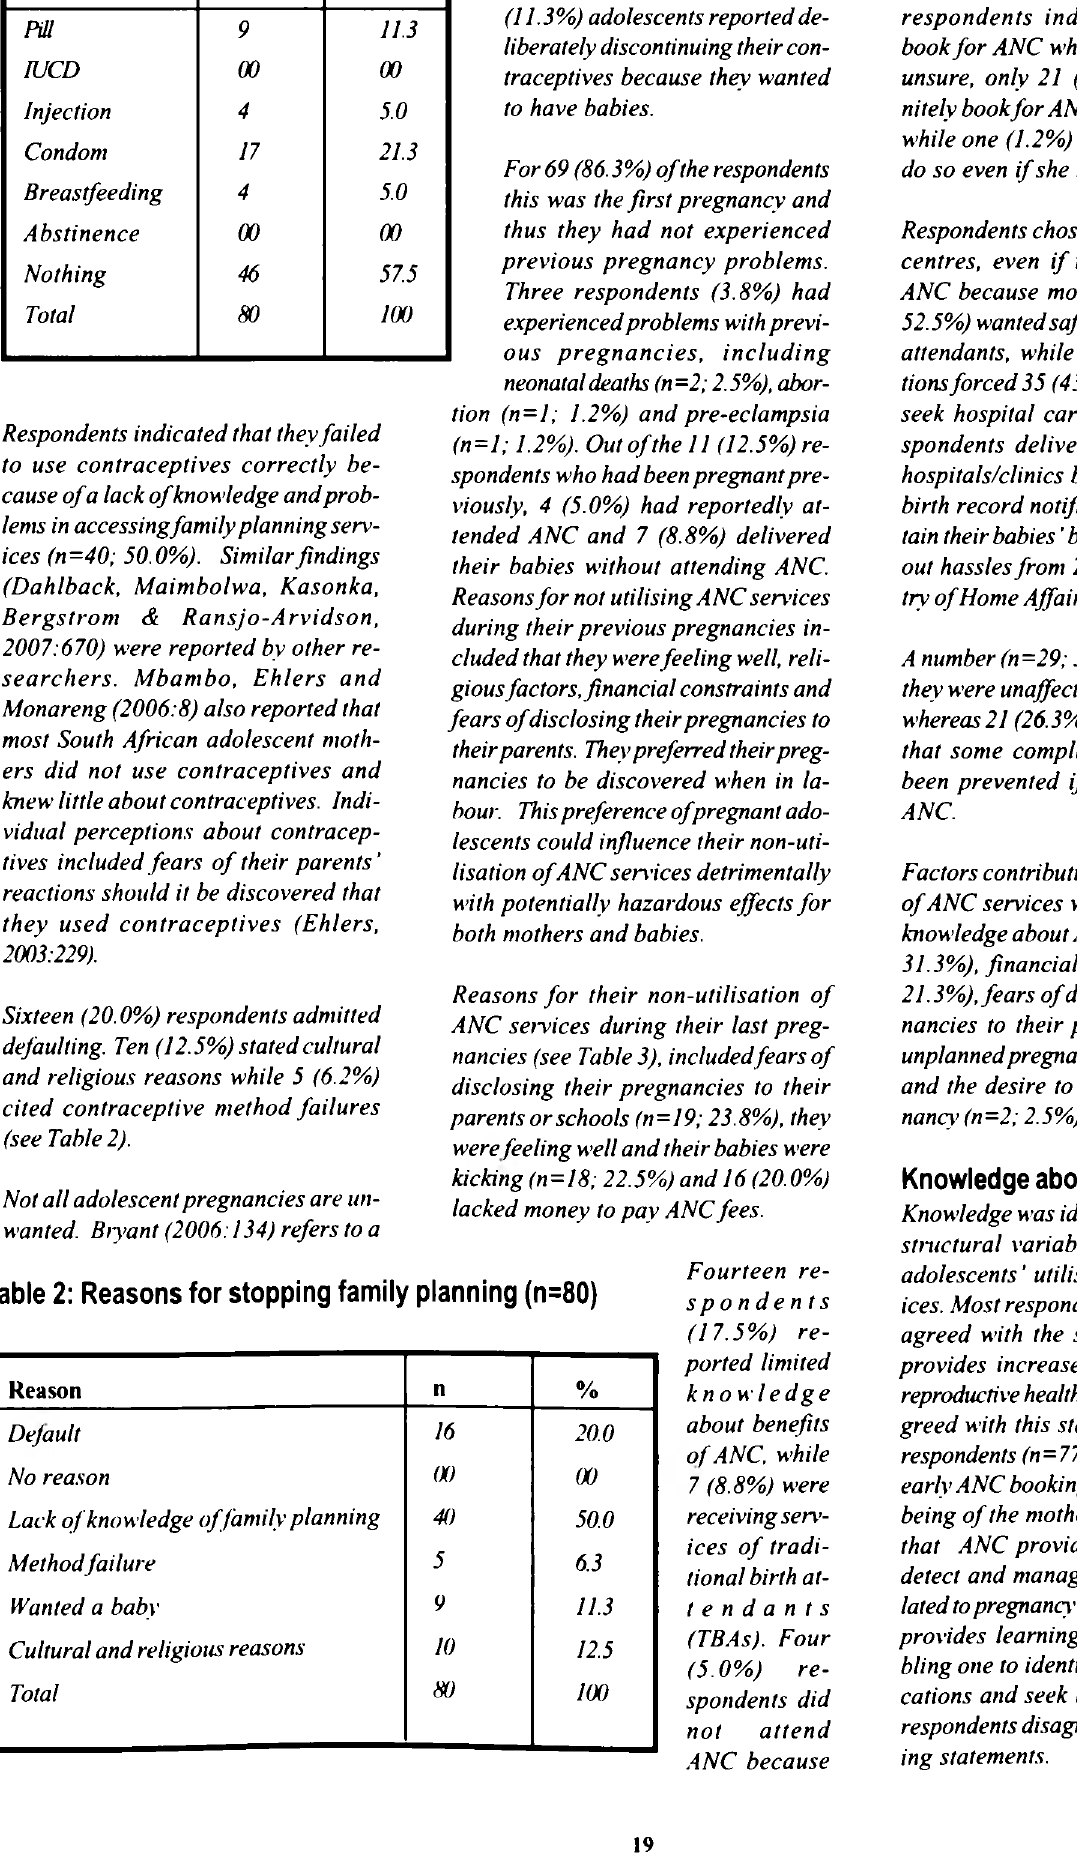
Table 2: Reasons for stopping family planning (n=80)